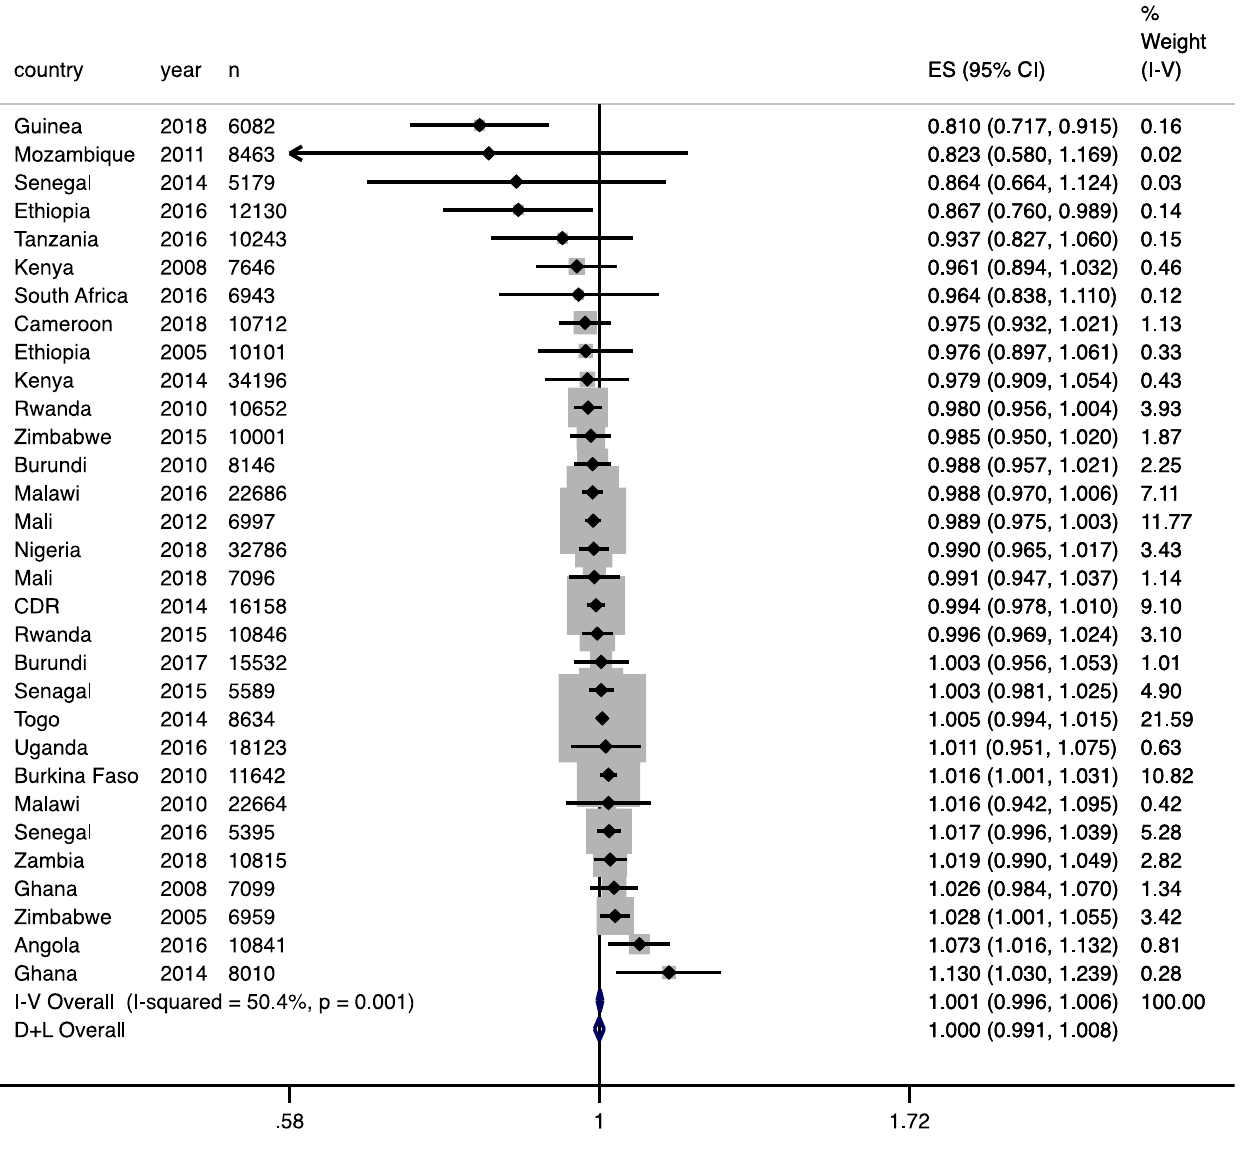
Figure 1. Associations between prior-month PM 2.5 concentration (per 1 µ g/m 3 higher) and prevalence of cough in the past two weeks across DHS in sub-Saharan Africa.